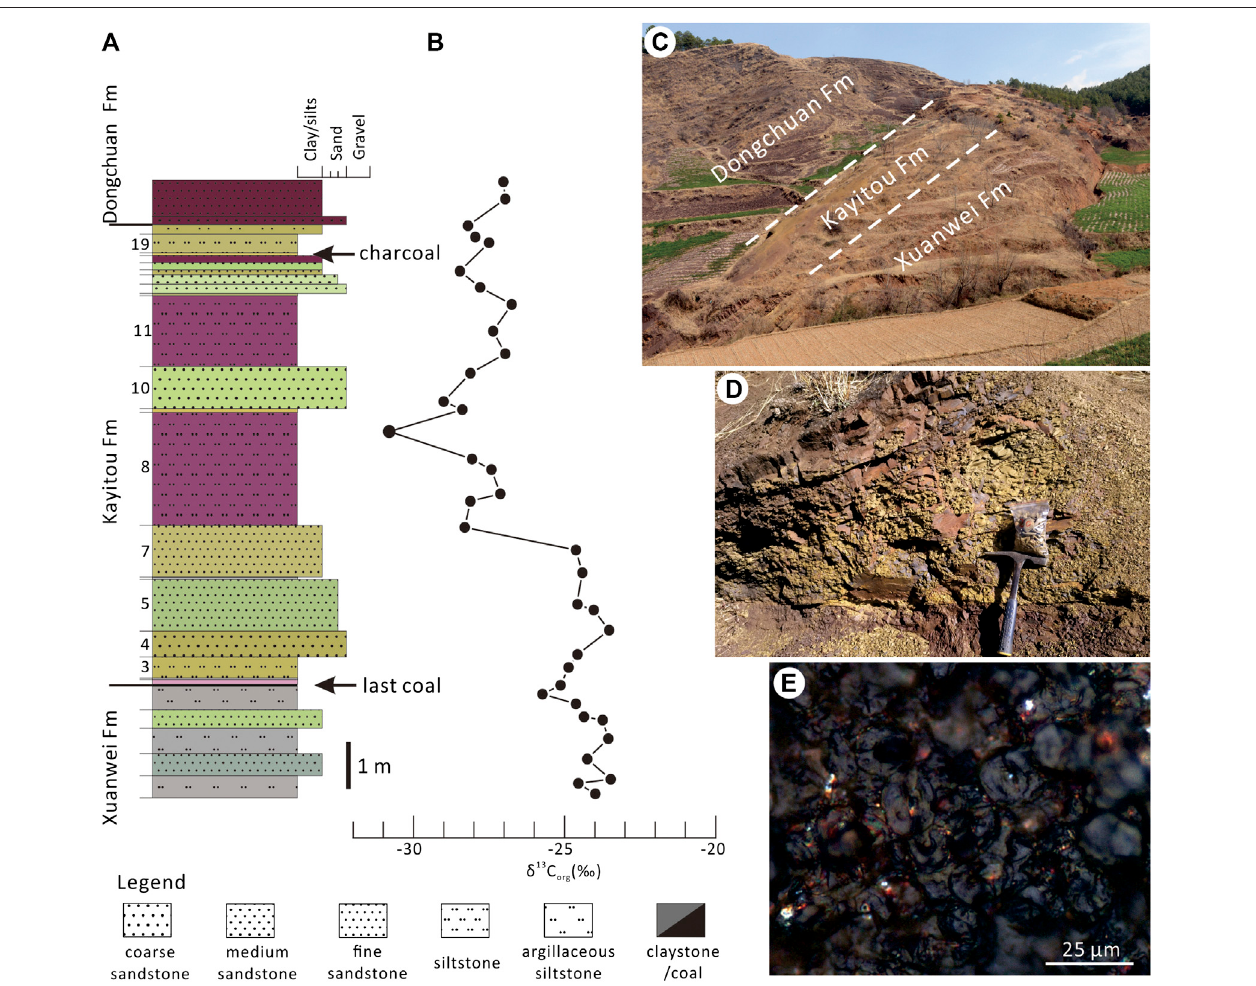
FIGURE3| Litholoigcalcolumnand fi eldphotographsoftheKayitouFormationoftheLubeisectioninYunnanProvince,SouthwestChina. (A) Stratigraphiccolumn showingthelitho-faciesoftheKayitou Formation (Fm). (B) Organiccarbon curve throughtheKayitou Formation (fromZhangetal.,2016). (C) Overview fi eldphotograph showing the Xuanwei, Kayitou, and Dongchuan formations. (D) Close-up photograph the fossil-bearing bed. (E) Microphotograph of the charcoali fi ed leaf from the Kayitou Formation, note the silky luster of the epidermal cells.